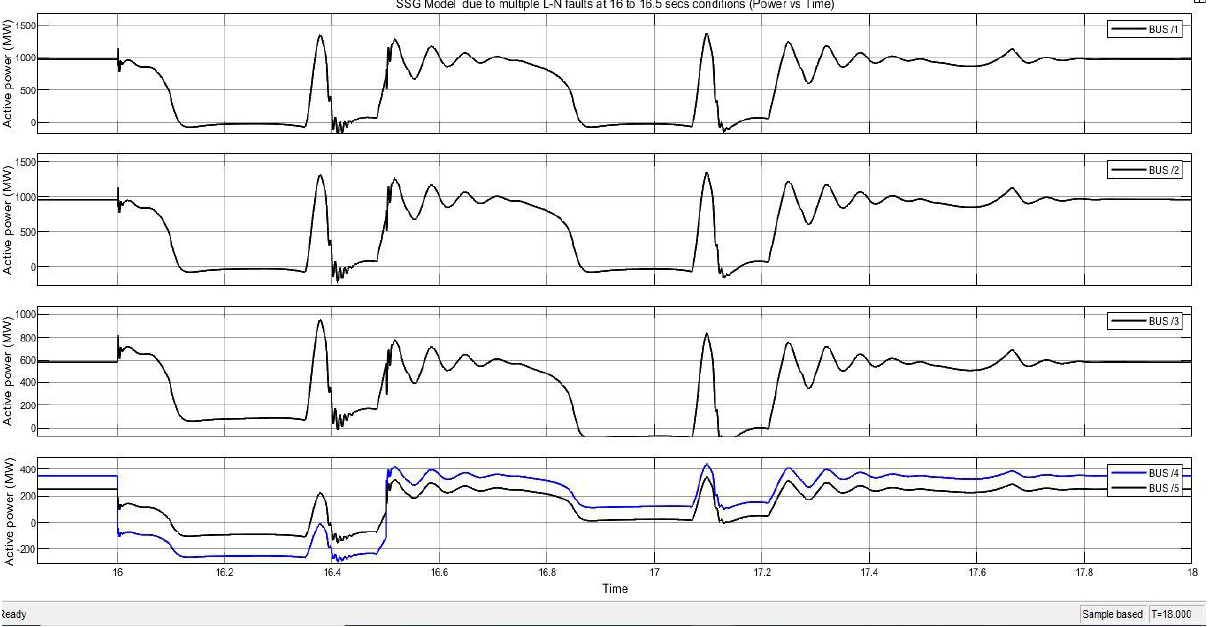
Figure 20. Multiple line-to-ground faults are inserted in the system from 12 to 12.3 s and 16 to 16.5 s (Bus 6 to Bus 10).